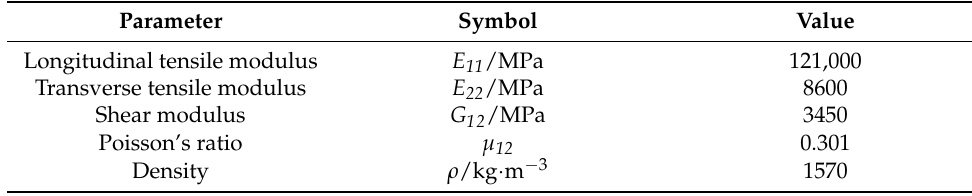
Table 1. Material properties of USN15000/7901/RC33 [37].